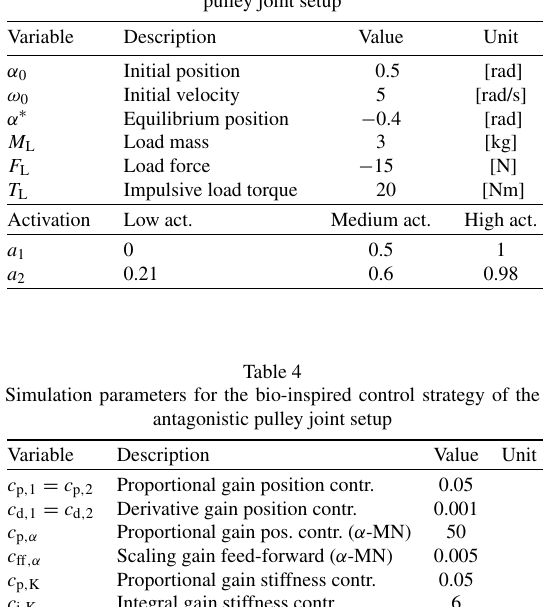
Table 3 Simulation parameters for the stability analysis of the antagonistic